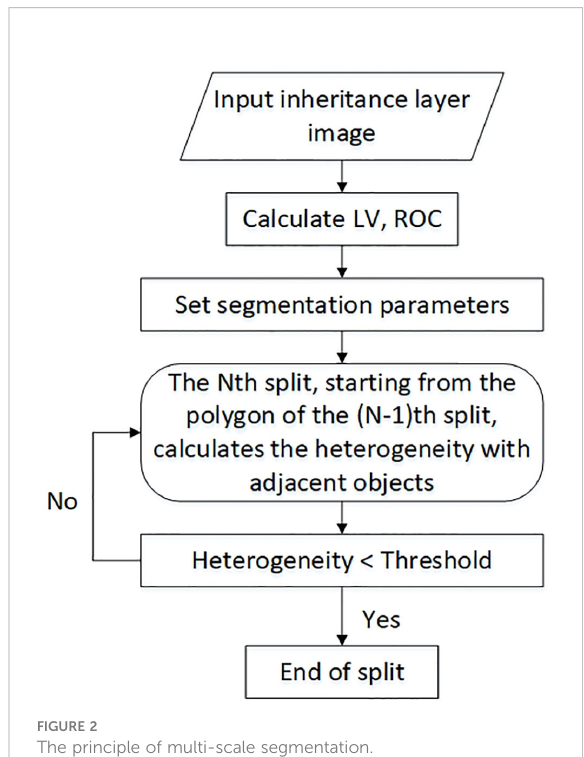
FIGURE 2 The principle of multi-scale